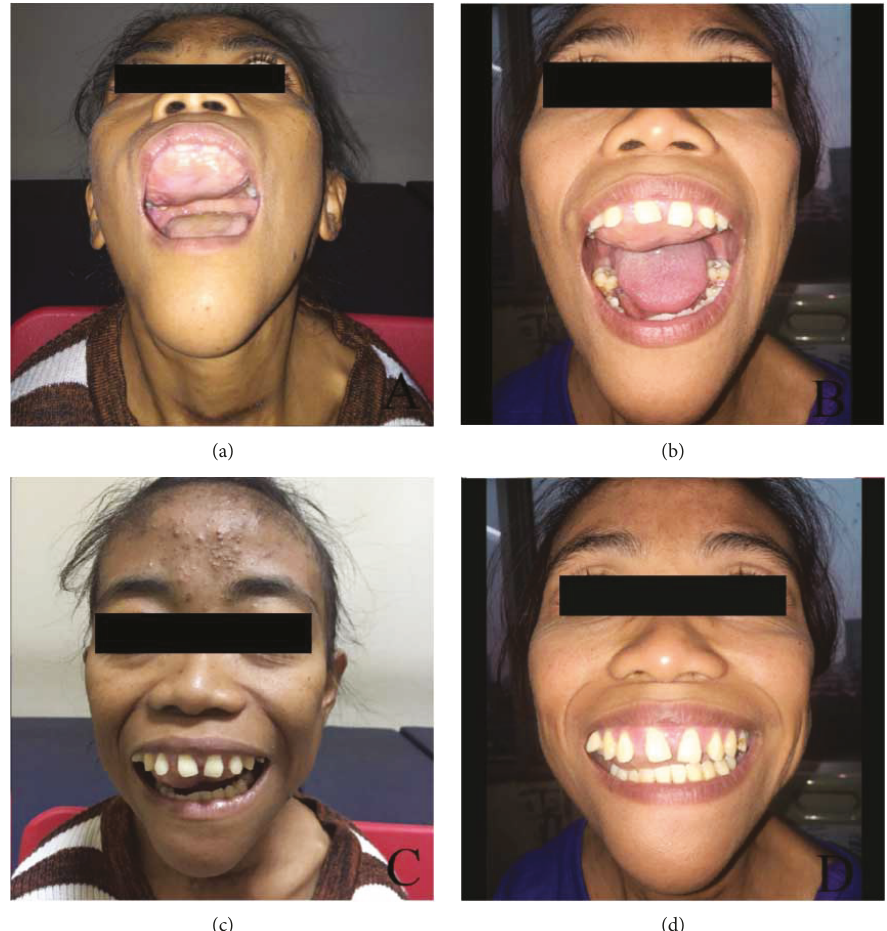
Figure 1: Case 1. (a) Hard palate mass. (b) Facial asymmetry due to the mass. (c, d) Regressed mass after